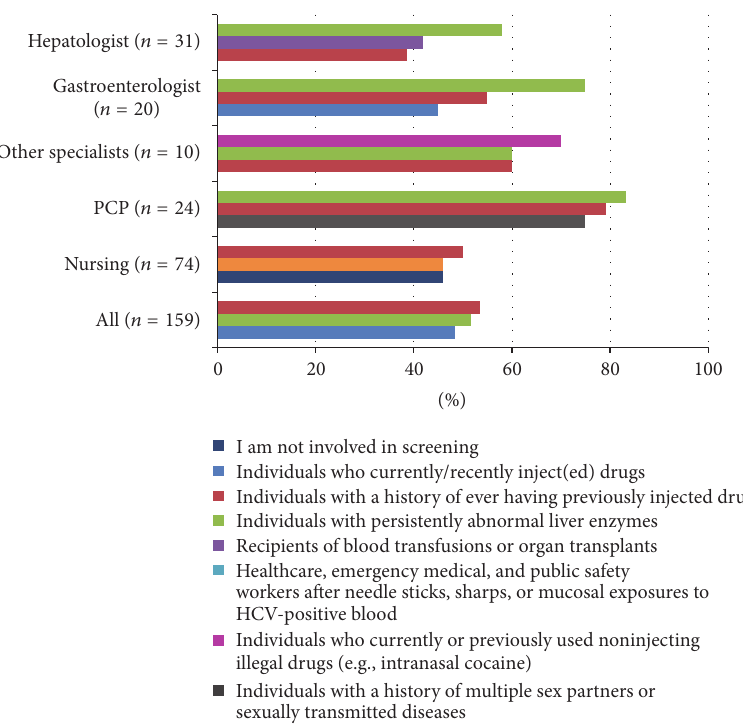
Figure 2: Participants selection factors for screening patients for hepatitis